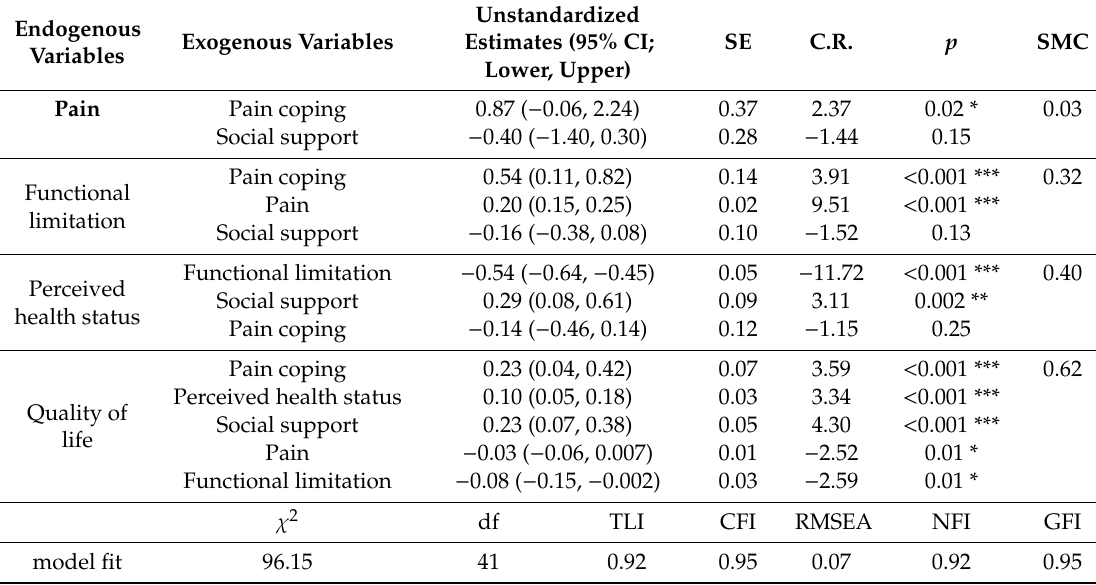
Table 3. The structural equation model of quality of life (QOL) among elderly people experiencing chronic musculoskeletal pain